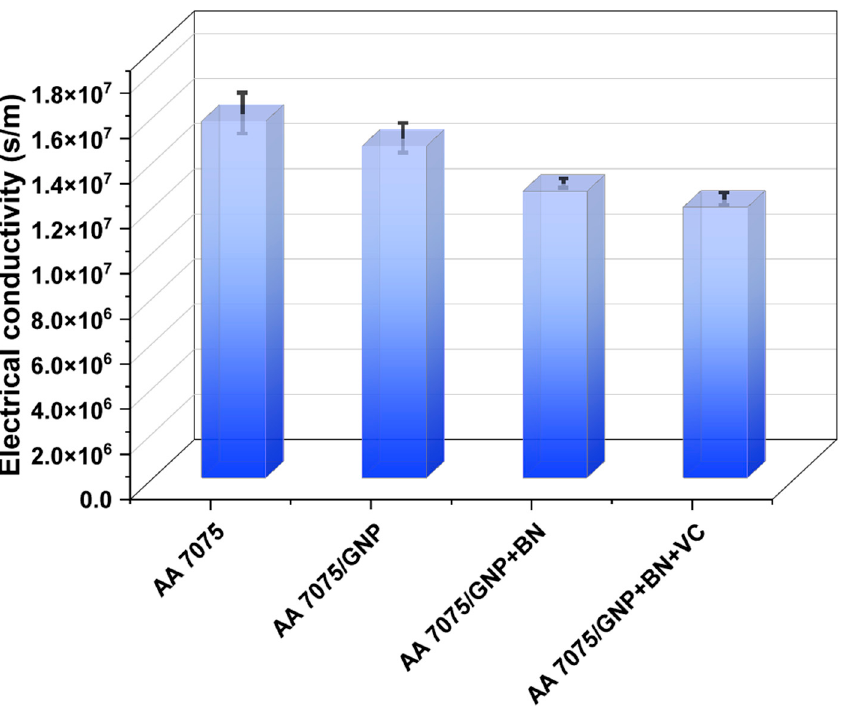
Figure 10. The electrical conductivity of the investigated alloy and fabricated composites.